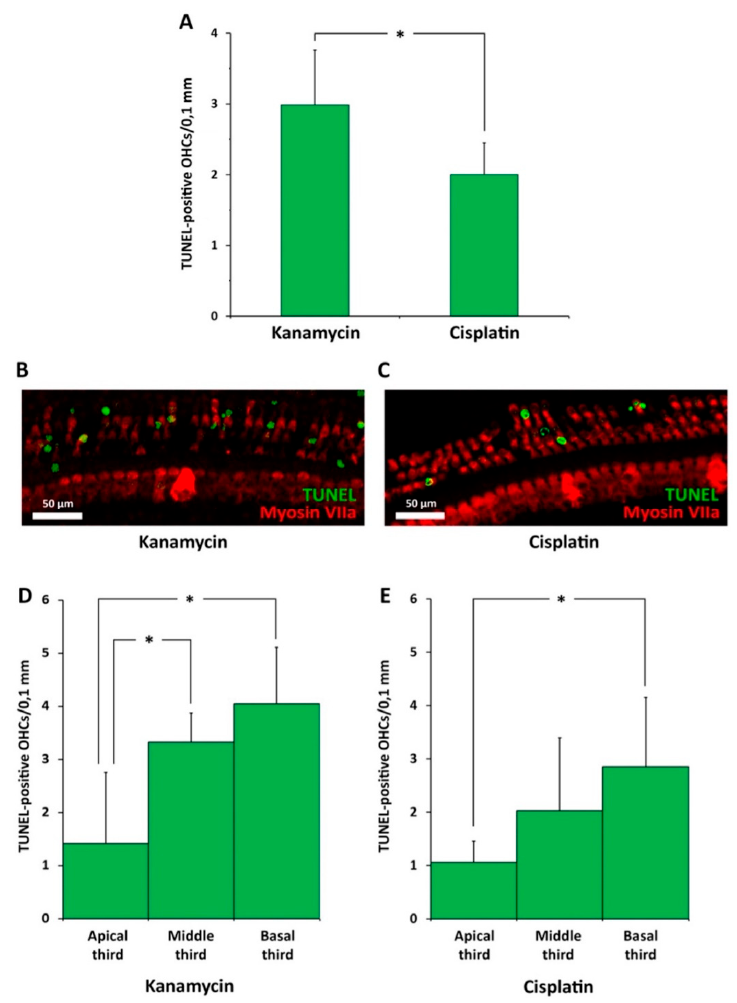
Figure 5. Comparison of apoptosis after kanamycin and cisplatin ototoxicity with the TUNEL method in the transition zone. ( A ): Average number of apoptotic nuclei/0.1 mm length in the transition zone in rats treated with kanamycin (D15) and cisplatin (72 h). ( B ): Apoptotic, TUNEL + nuclei present in the transition zone after treatment with kanamycin (D15). ( C ): TUNEL + nuclei in the transition zone after treatment with cisplatin (72 h). ( D ): Average apoptotic nuclei/0.1 mm length present in each of three thirds of the transition zone after treatment with kanamycin at D15. ( E ): Average number of apoptotic, TUNEL + nuclei/0.1 mm length present in each third of the transition zone, 72 h after treatment with cisplatin. The denomination “apical,” “middle” and “basal” third is in relation to the length of the transition zone and not to cochlear turns. Asterisks indicate statistical significance values, as specified in Section 2.6, Materials and Methods.